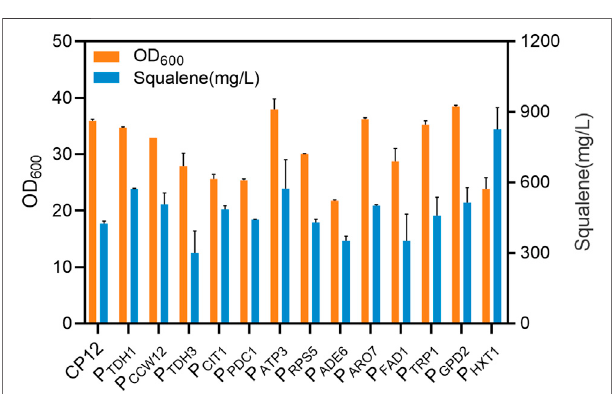
FIGURE 2 | Biomass concentrations and squalene contents of constructedstrains,resultingfrompromotersubstitution,after 96 hofculture. The promoter of ERG1 (the squalene monooxygenase gene) was replaced by 13 different promoters: P TDH1 , P CCW12 , P TDH3 , P CIT1 , P PDC1 , P ATP3 , P RPS5 , P ADE6 , P ARO7 , P FAD1 , P TRP1 , P GPD2 , and P HXT1 . Error bars show SD